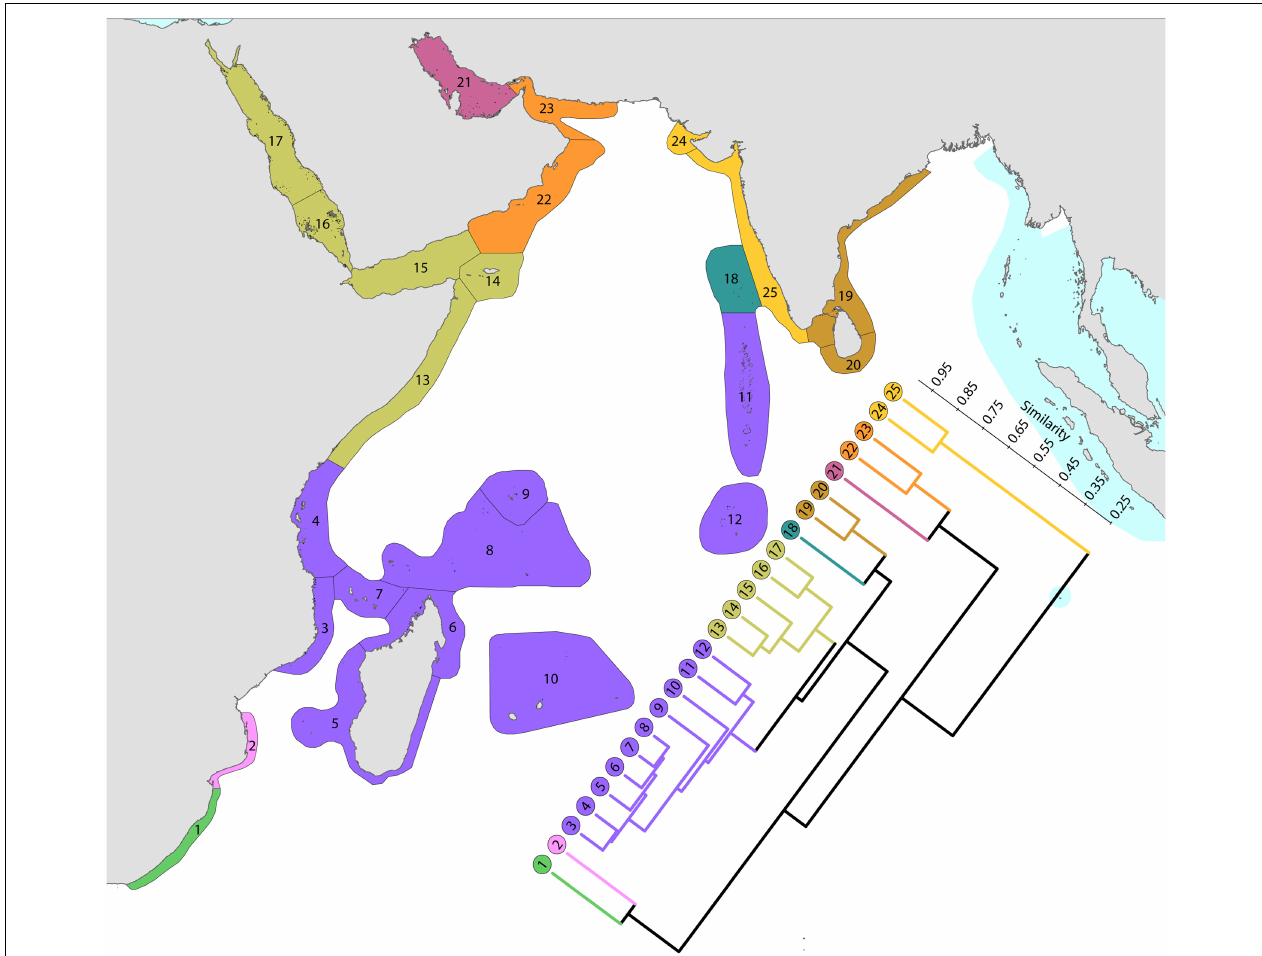
FIGURE 11 | Affinity and diversity of ecoregions of the western Indian Ocean and Red Sea. This dendrogram was produced by the progressive exclusion of outlying ecoregions; there were no